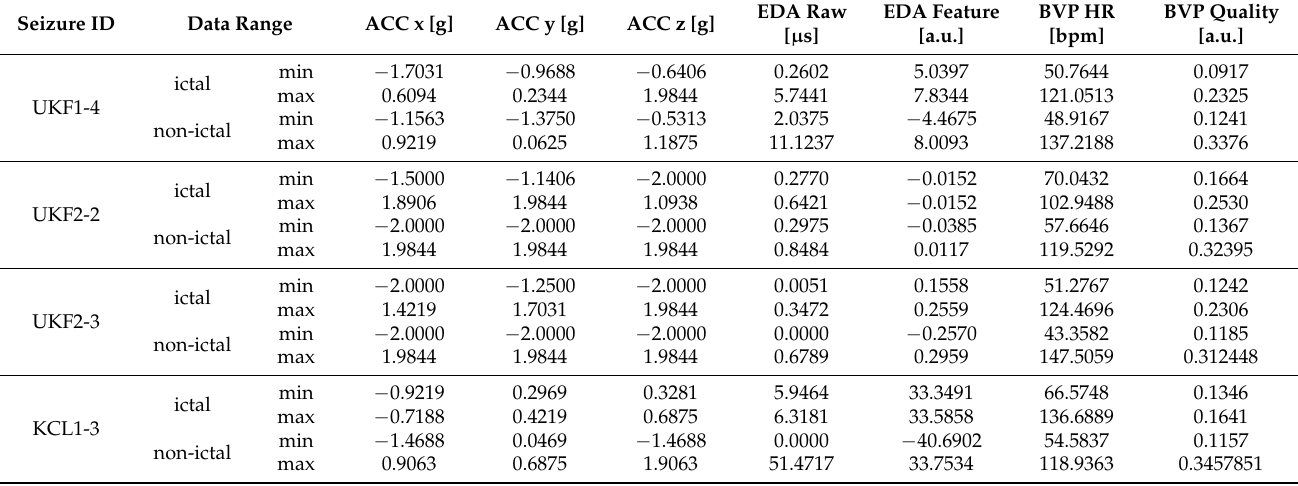
Table A3. The original value ranges for the plotted data in Figures 3 and 5, before